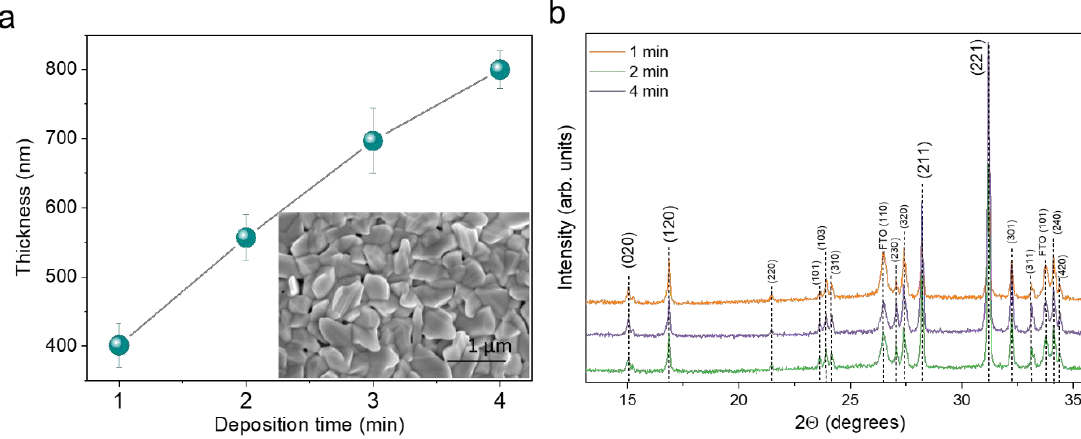
Figure 4. ( a ) An average absorber thickness determined from cross-sectional SEM images as a func- tion of deposition time in the last process step. Inset — top-view SEM image of Sb 2 Se 3 absorber de- posited at 3 min. ( b ) XRD patterns of Sb 2 Se 3 absorbers grown at different deposition times. All XRD peaks were assigned to orthorhombic Sb 2 Se 3 phase (PDF 01-089-0821) and SnO 2 (PDF 00-041-1445).